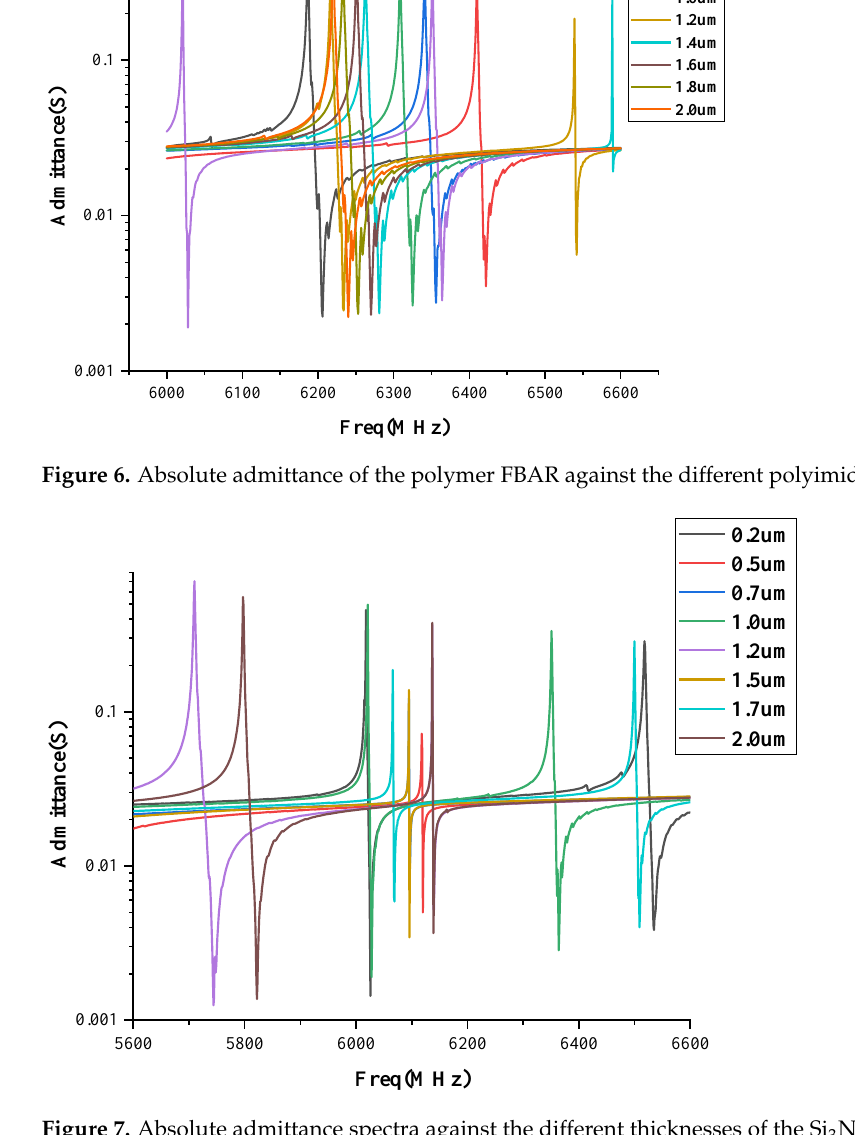
Figure 6. Absolute admittance of the polymer FBAR against the different polyimide thicknesses.